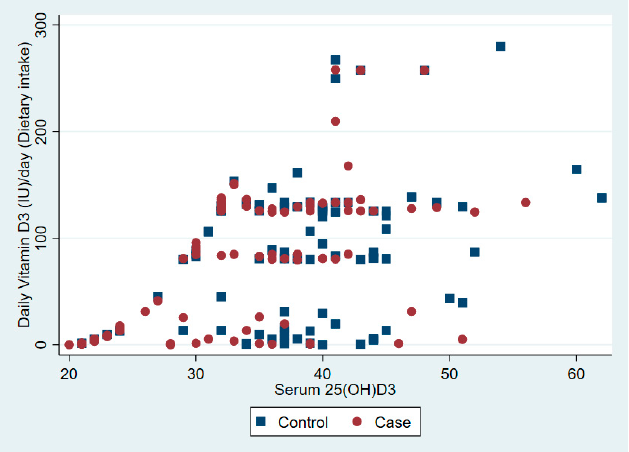
Figure 1. The association between serum vitamin D 25(OH)D and daily vitamin D from dietary intake.